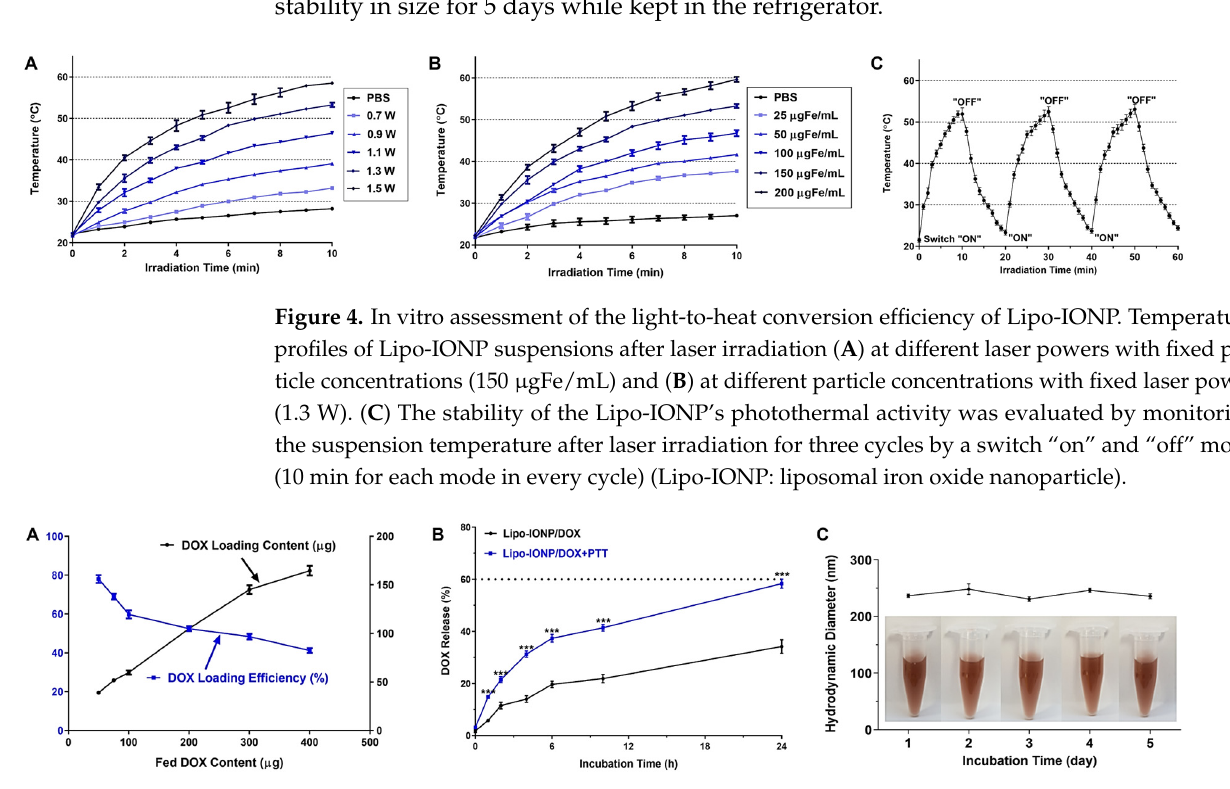
9 of 17 Figure 3. Fourier transform infrared (FT-IR) spectroscopic profiles of Lipo-IONP. The characteristic peaks of the samples are shown in dashed lines. The distinct peaks of the oleic acid composing OA- IONP (at 1733, 2854, and 2923 cm − 1 ) and lipid mix (at 1100 cm − 1 ) were identified from the FT-IR spectrum of the Lipo-IONP (Lipo-IONP: liposomal iron oxide nanoparticle). 3.2. Photothermal Activity of Lipo-IONP The light-to-heat conversion capacity and photostability of the Lipo-IONP were eval-